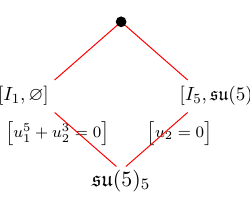
Figure 2 . Hasse diagram for the CB of the theory with su (5) 5 flavor